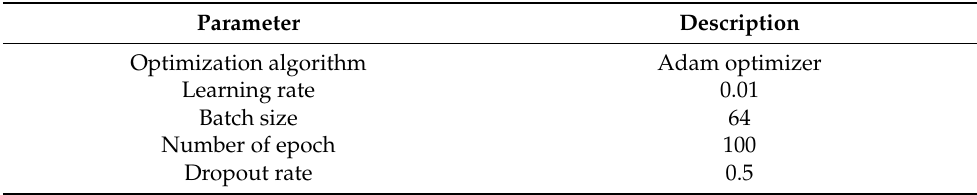
Table 1. Training parameters of the multi-input image DCNN